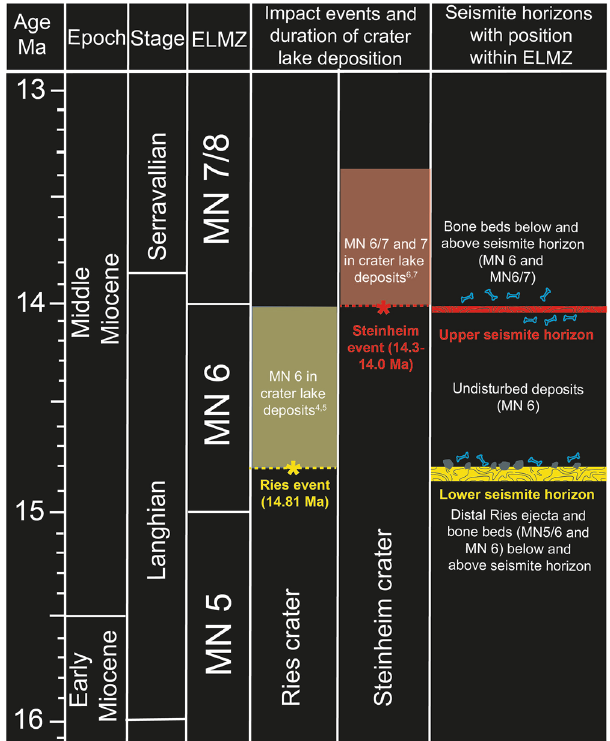
Figure 8. Chrono- 59 and biostratigraphic 12 classification of the crater infill of the Ries and the Steinheim